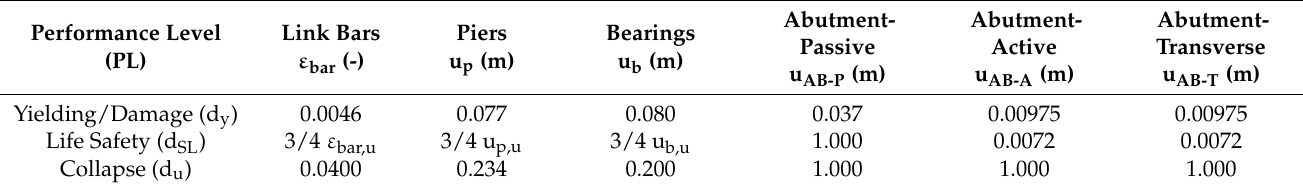
Table 3. Performance levels and related demand threshold values for the bridge components.